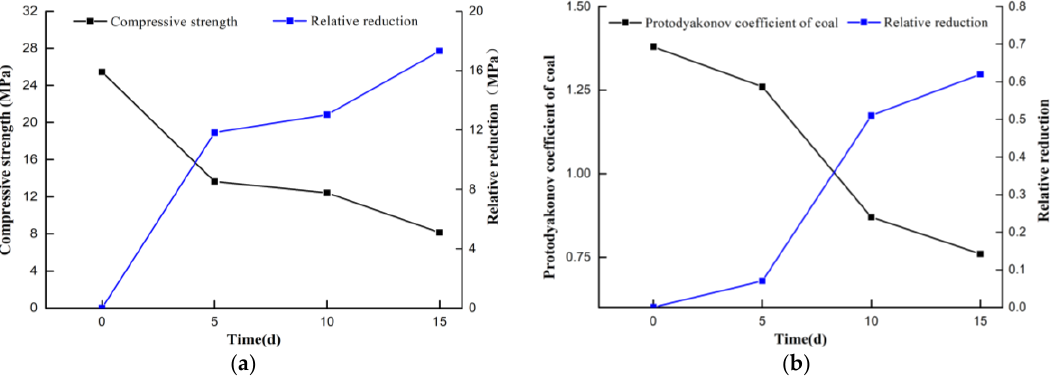
Figure 2. The change of mechanical parameters of coal with soaking duration: ( a ) compressive strength and ( b ) Protodyakonov coefficient.